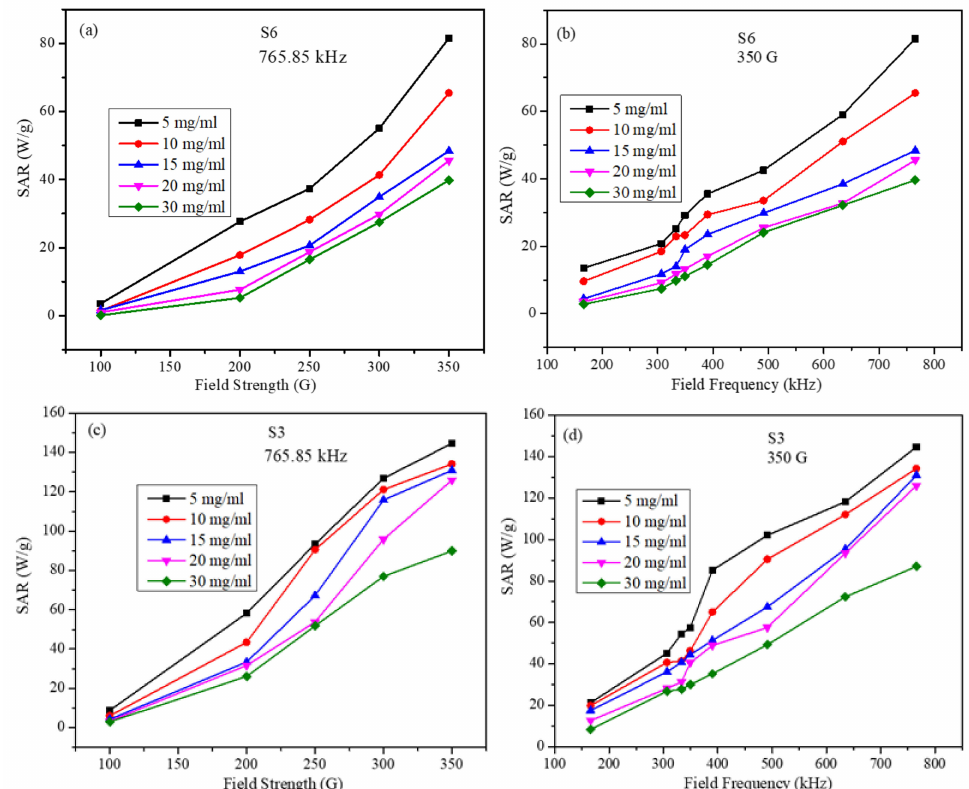
Figure 6. SAR values ( a ) for S6 sample as a function of the field strength at a fixed frequency for several particle concentra- tions, ( b ) for S6 sample as a function of the field frequency at fixed strength for several particle concentrations, ( c ) for S3 sample as a function of the field strength at a fixed frequency for several particle concentrations, and ( d ) for S3 sample as a function of the field frequency at fixed strength for several particle concentrations (lines in figures are just to guide the